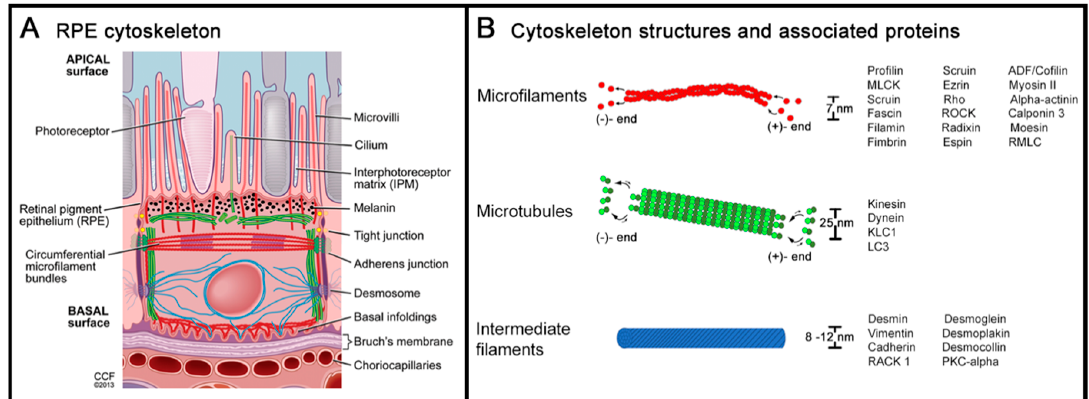
Figure 1. The cytoskeleton of the retinal pigment epithelium (RPE). ( A ) A cross-sectional view of the RPE and the adjacent photoreceptor outer segments (apical) and Bruch membrane (basal) highlights the intracellular network of cytoskeleton proteins: actin filaments, microtubules, and intermediate filaments. ( B ) The graph plots the dimension and protein structure of the above-mentioned cytoskeleton members: microfilaments consist of helical arranged polymers of actin proteins with an ATP-rich assembling ( + )-end and a less energetic, ADP-rich disassembling (-)-end. Microtubules are hollow cylinders of tubulin proteins, also possessing an energetic, GTP-rich assembling ( + )-end and a less energetic GDP-rich disassembling (-)-end. Intermediate filaments form rope-like fibers consisting of a large group of filament-organizing proteins. The regulating and associated proteins of each of the cytoskeleton substructures as mentioned in this review are listed (for details and additional regulating proteins, see detailed reviews from Bonilha and Hohmann et al. [32,33]). Figure 1A: a reprint